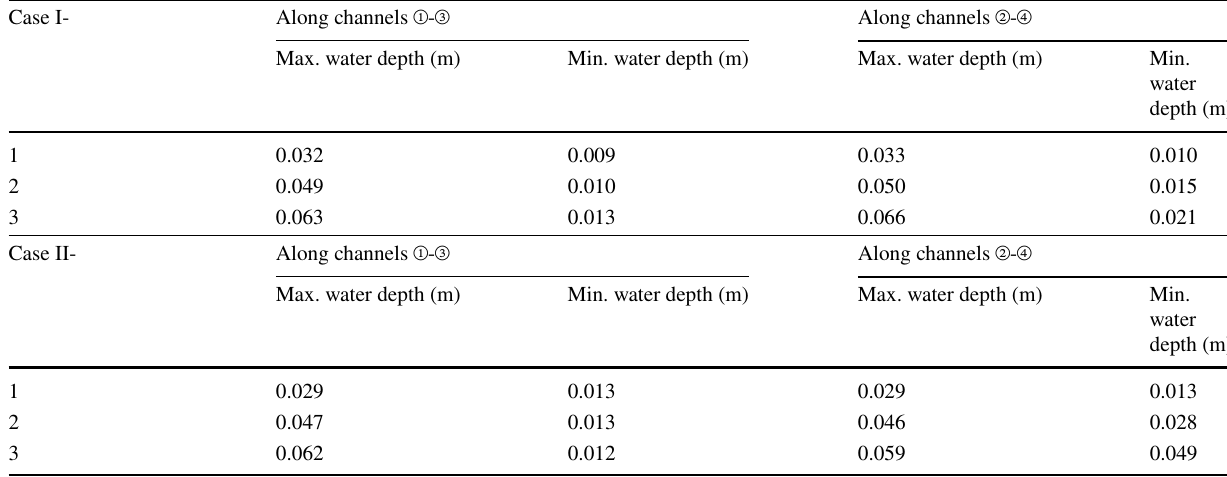
Table 6 Comparison of maximum and minimum water depths for Case I and II Case